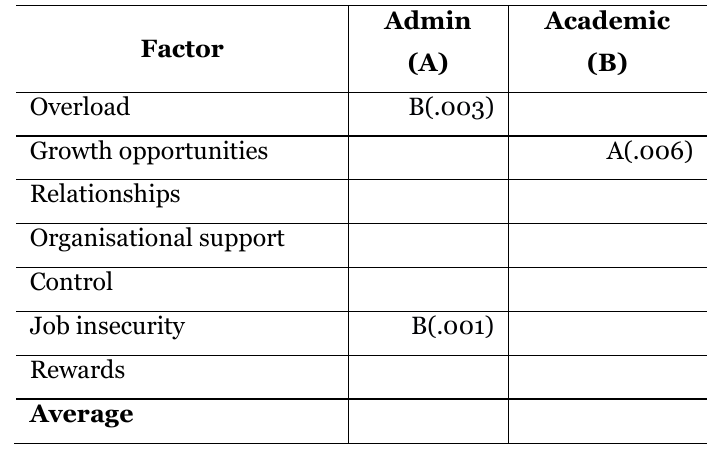
Table 4.3 Bonferroni Correction for Pairwise